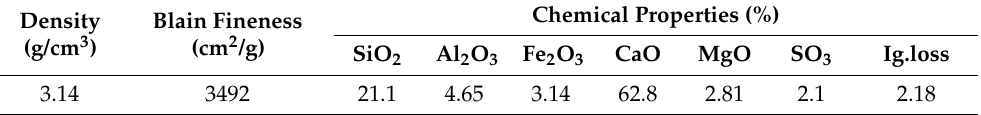
Table 2. Physical and chemical properties of ordinary Portland cement (OPC).